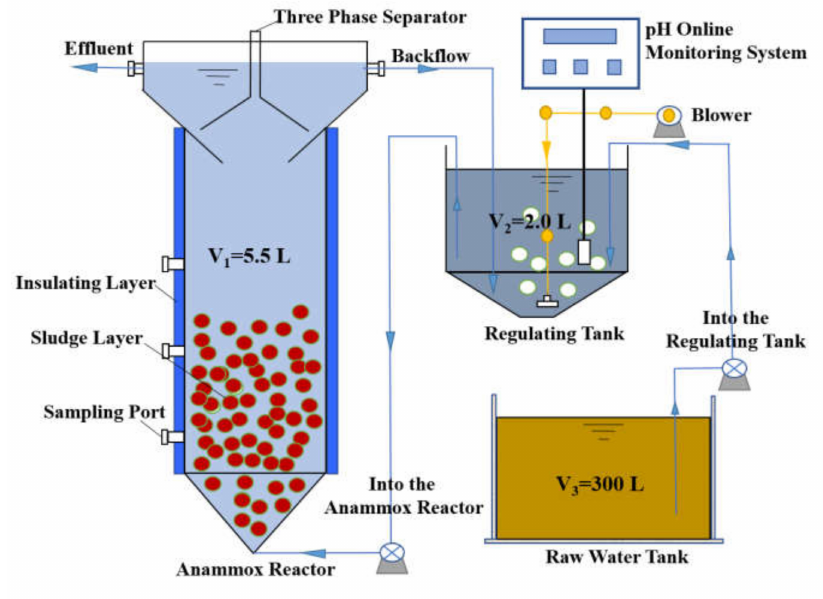
Figure 1. Schematic diagram of the reactor.